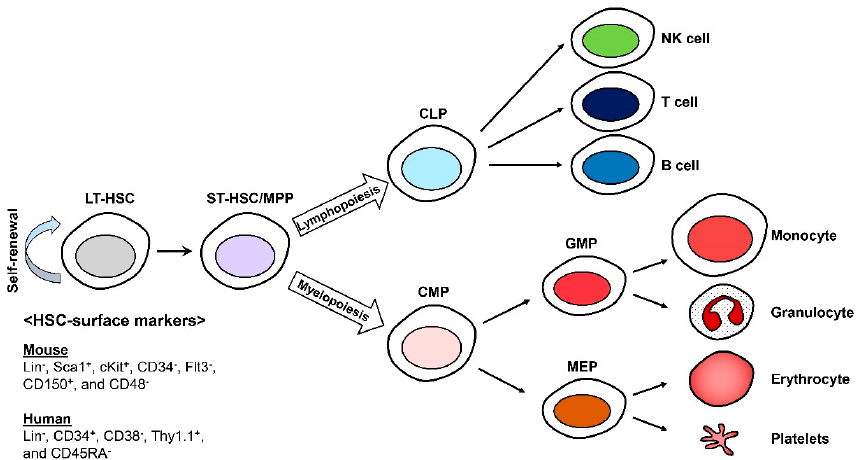
Figure 1. Differentiation of hematopoietic stem cells (HSCs). Long-term HSCs (LT-HSCs) are able to self-renew and are responsible for generating blood cells. CLP; the common lymphoid progenitor, CMP; the common myeloid progenitor, GMP; the granulocyte macrophage progenitor, and MEP; the megakaryocytic and erythroid progenitor.